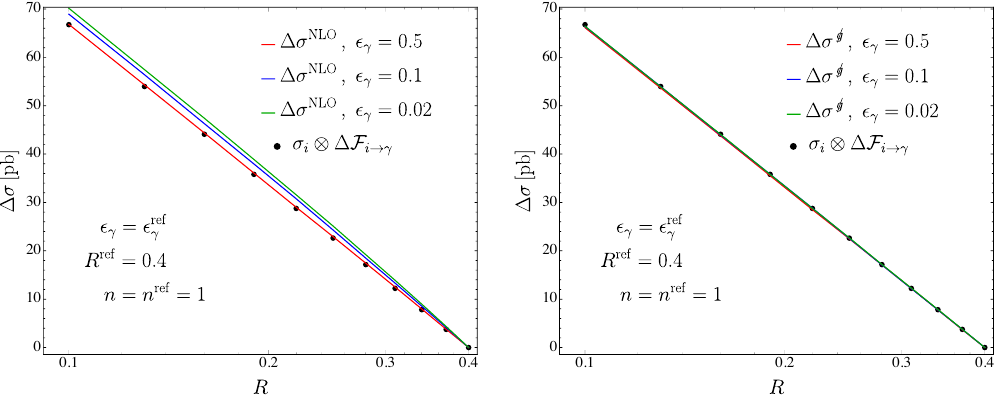
Figure 4 . Dependence of ∆ σ on the cone radius R for smooth-cone isolation (1.2). The lines labeled ∆ σ NLO are the difference of the full NLO cross sections. For the lines labeled ∆ σ g/ in the right plot gluons inside the isolation cones were vetoed. The dots represent ∆ σ = σ i ⊗ ∆ F i → γ computed with the fragmentation function according to (3.16), which is independent of (cid:15) γ for (cid:15) γ = (cid:15) ref